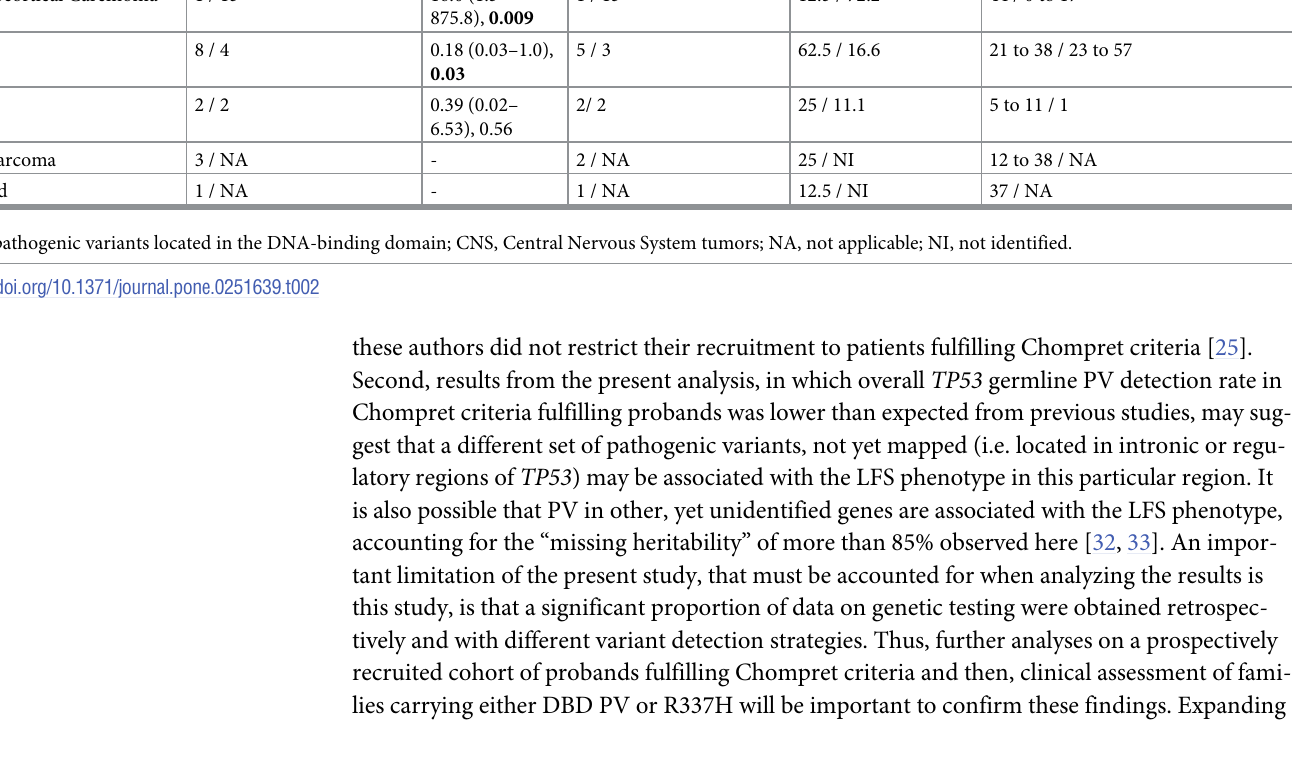
Table 2. Distribution of tumor types in all LFS PV-positive patients (n = 26). Tumor types diagnosed in PV carriers